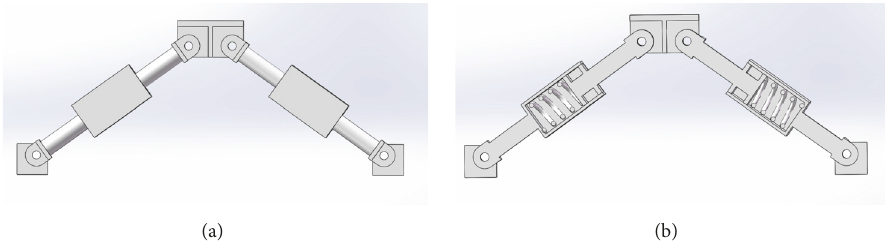
Figure 2: Model of oblique spring: (a) 3D, (b) cross